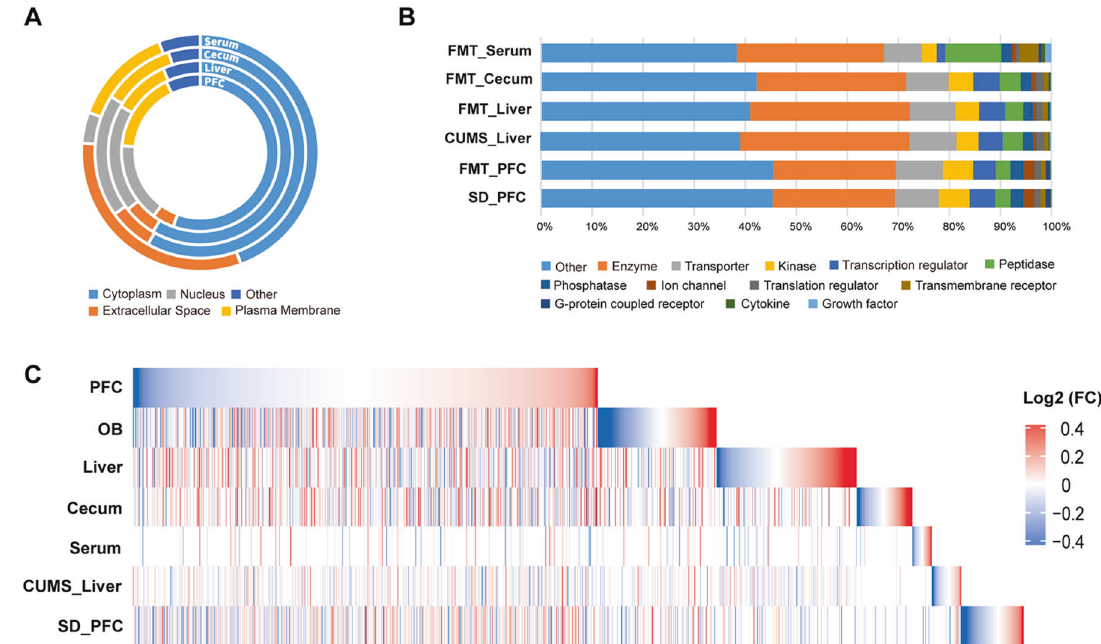
Fig. 2 Protein expression pro fi le. A Donut plots represent the percentages of cellular compartments of all proteins. B Composition of the functional groups annotated by IPA. In the PFC, about 2.1% of proteins involved in ion channel functions, which was approximately twice as high as that in the liver, cecum, and serum. The proportion of G protein-coupled receptors in the PFC was also three times higher than that in the cecum and liver. In the serum, the numbers of growth factors, cytokines, transmembrane receptors, and peptidases were markedly higher than that in the other three tissues. C Union heatmaps show fold changes of all proteins for the gut – brain axis of FMT model, the PFC of CSDS model, and the liver of CUMS